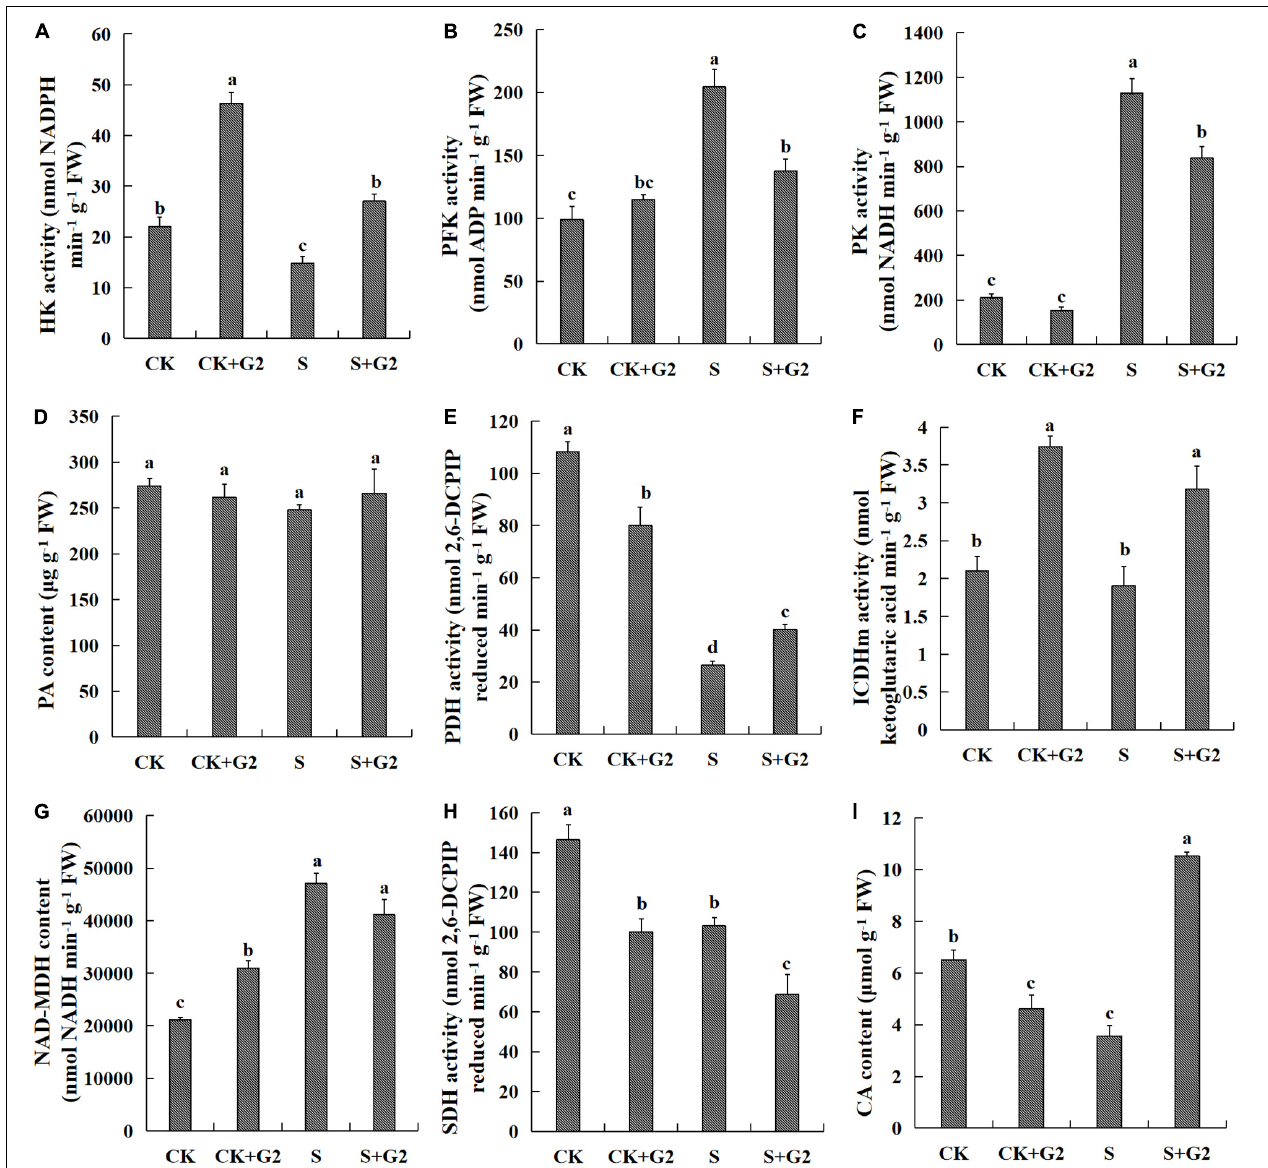
FIGURE 7 | Effects of B. cereus G2 on EMP-TCA-related enzyme activities and intermediate contents in G. uralensis seedlings under control and salt stress conditions. CK, control group; S, salt stress group; CK + G2, control combined with the G2 group; S + G2, salt stress combined with the G2 group. The different letters within the different treatments in the same parameter indicate the significant difference at the 0.05 level. Values are means ± SE ( n = 3). (A) HK: hexokinase. (B) PFK: phosphofructokinase. (C) PK: pyruvate kinase. (D) PA: pyruvate. (E) PDH: pyruvate dehydrogenase. (F) ICDH: isocitrate dehydrogenase. (G) MDH: malate dehydrogenase. (H) SDH: succinate dehydrogenase. (I) CA: